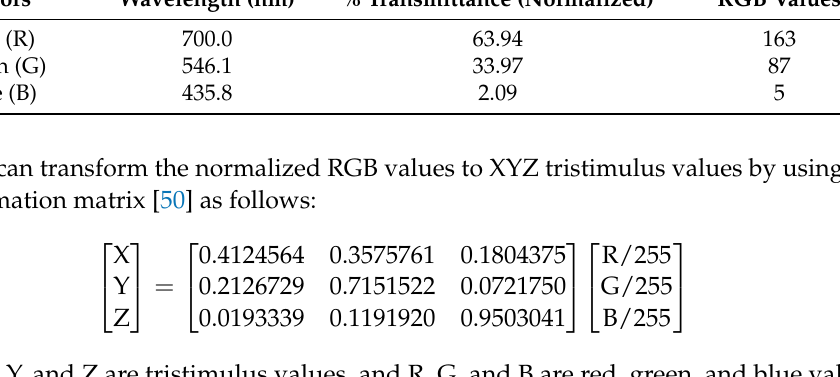
Table 1. Mapping of the transmittance to RGB values.